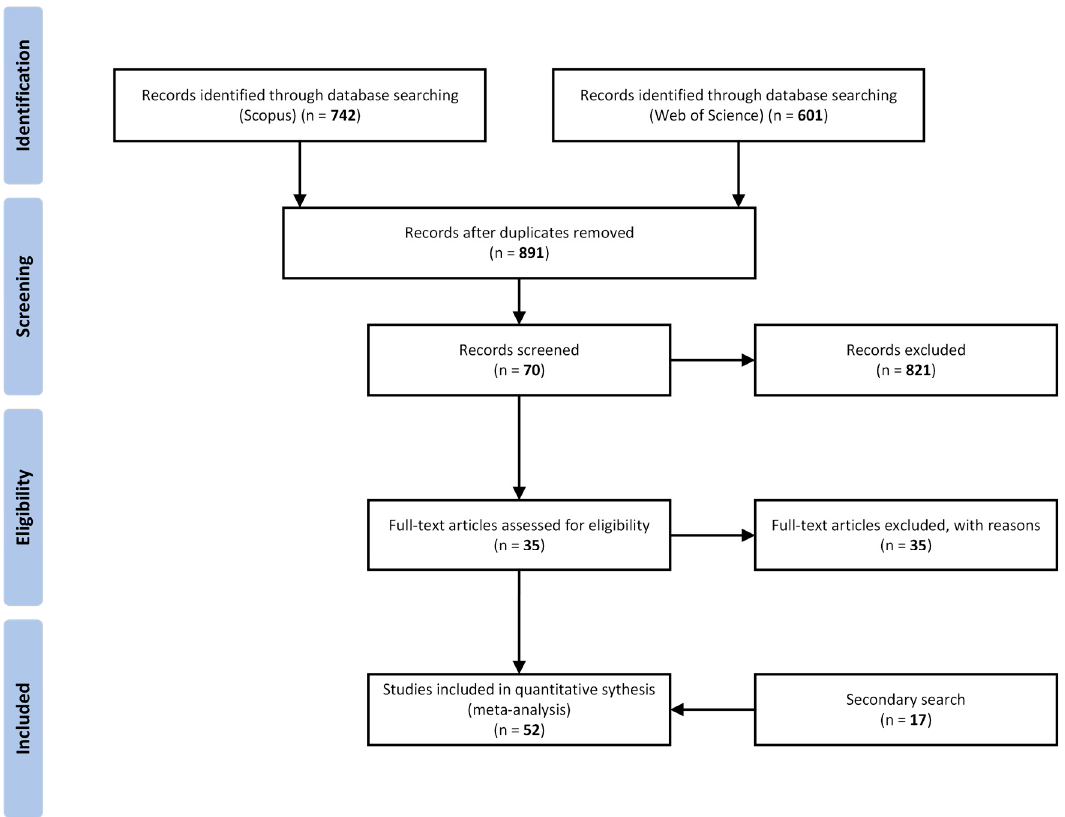
Figure 1. PRISMA flow diagram for article selection.